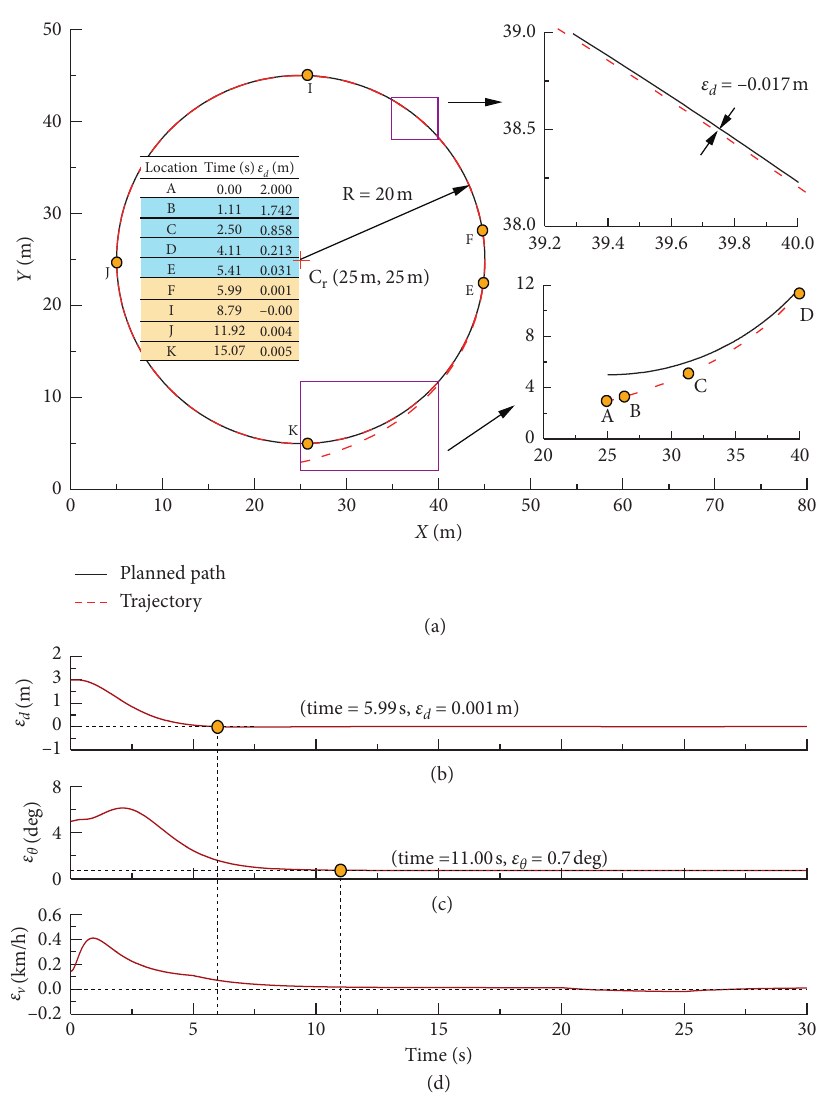
Figure 10: The control performances of the vehicle in the circular path-following